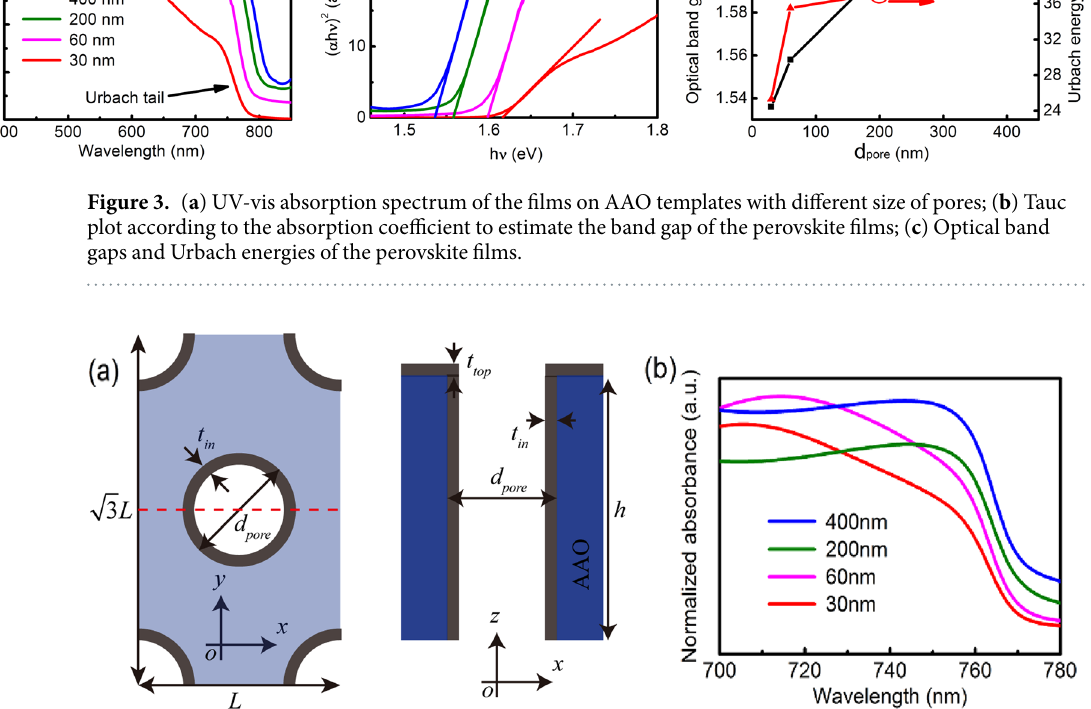
= 200 nm at the excitation intensity ranging from 0.058–0.743 μ W 3 NH 3 PbI 3 films on AAO template with d pore in Fig. 5c. When the excitation power intensity is higher than 0.75 μ W, the PL intensity of the CH 3 NH 3 PbI 3 film